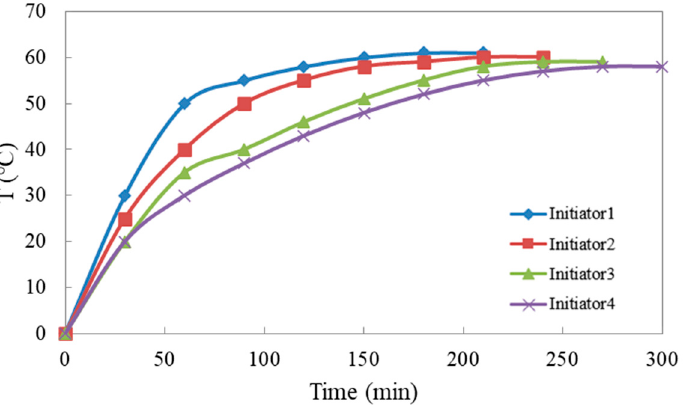
Figure 7. Temperature rise curve for initiator polymerization. Initiator1: K 2 S 2 O 8 + NaHSO 4 ; Initia- tor2: (NH 4 ) 2 S 2 O 8 + NaHSO 4 ; Initiator3: DTBP + NaHSO 4 ; Initiator4: K 2 S 2 O 8 + DTBP + NaHSO 4 .